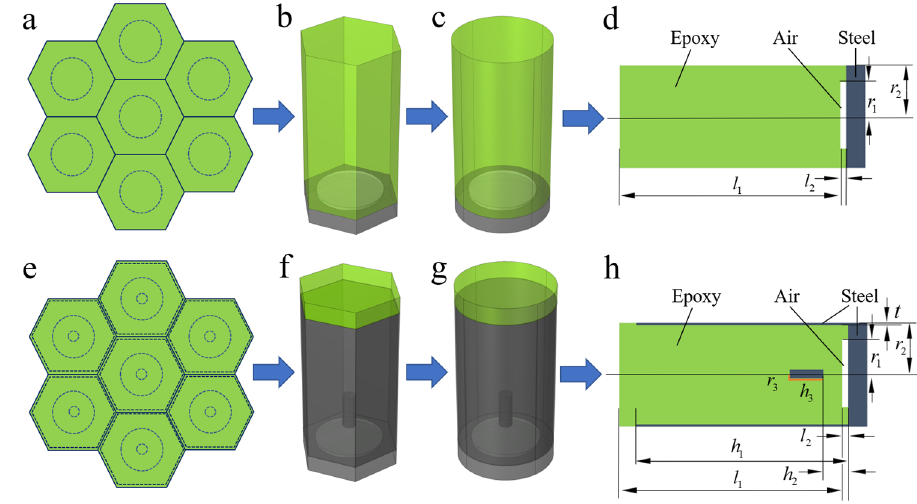
Figure 1. ( a – d ) are the top view, hexagonal cell, cylindrical cell, and cross-sectional of SSC; ( e – h ) are the top view, hexagonal cell, cylindrical cell and cross-sectional of NSSC. Table 1. The geometric parameters of the UAL (mm). Table 2. Material parameters “Adapted with permission from Ref. [26]. 2020, Elsevier Ltd.”.